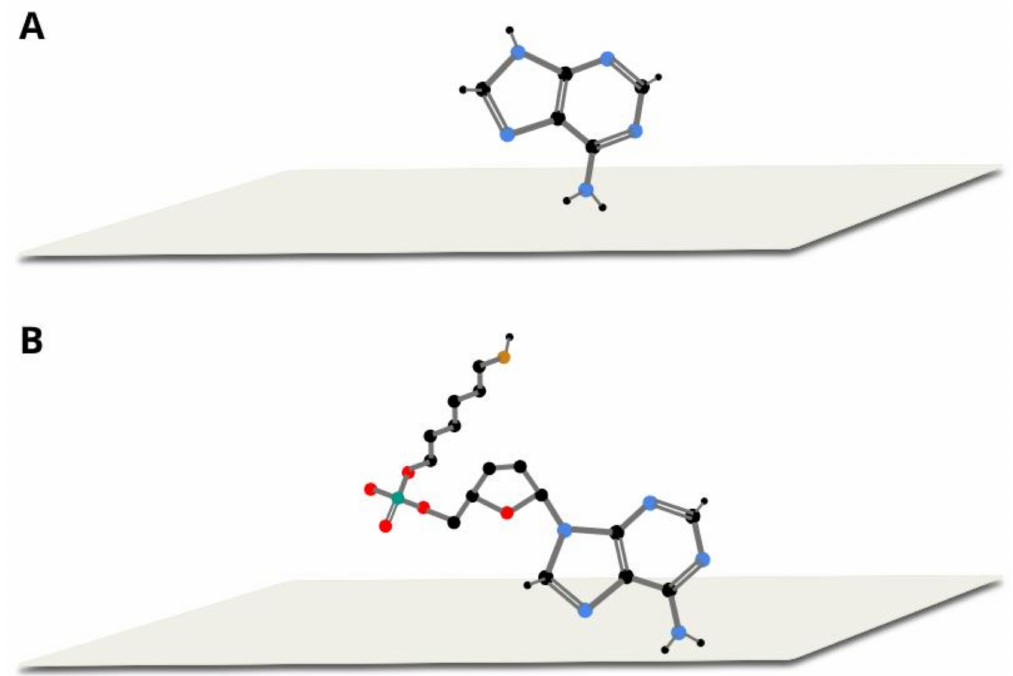
Figure 5. Proposed orientation of adenine ( A ) and thiolated adenine mononucleotide ( B ) on gold colloidal